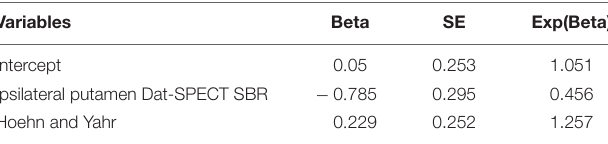
TABLE 5 | Data driven model 2 to predict motor progression in individuals with PD.